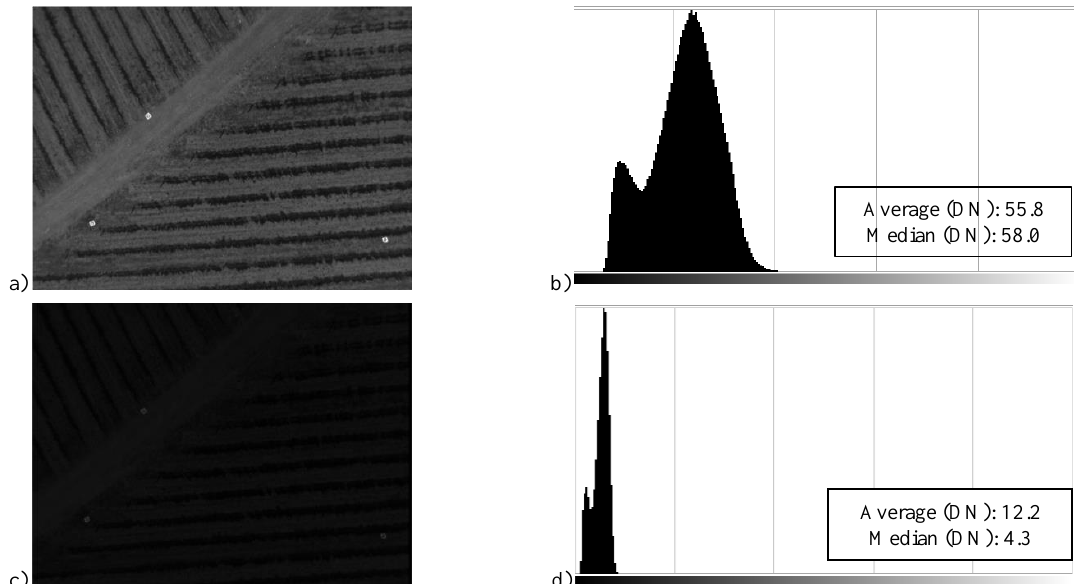
Figure 6: Monochromatic image in band 1 (Violet) of MAIA/S2 (a) with the corresponding histogram (b) before radiometric correction; the same image (c) and corresponding histogram (d) after applying the radiometric correction for the irradiance light using a white